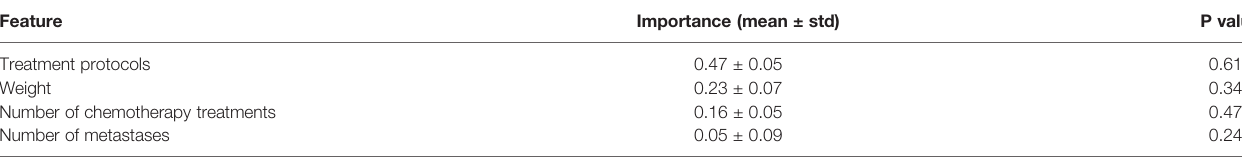
TABLE 2 | Feature importance from TabNet with six-fold cross-validation.